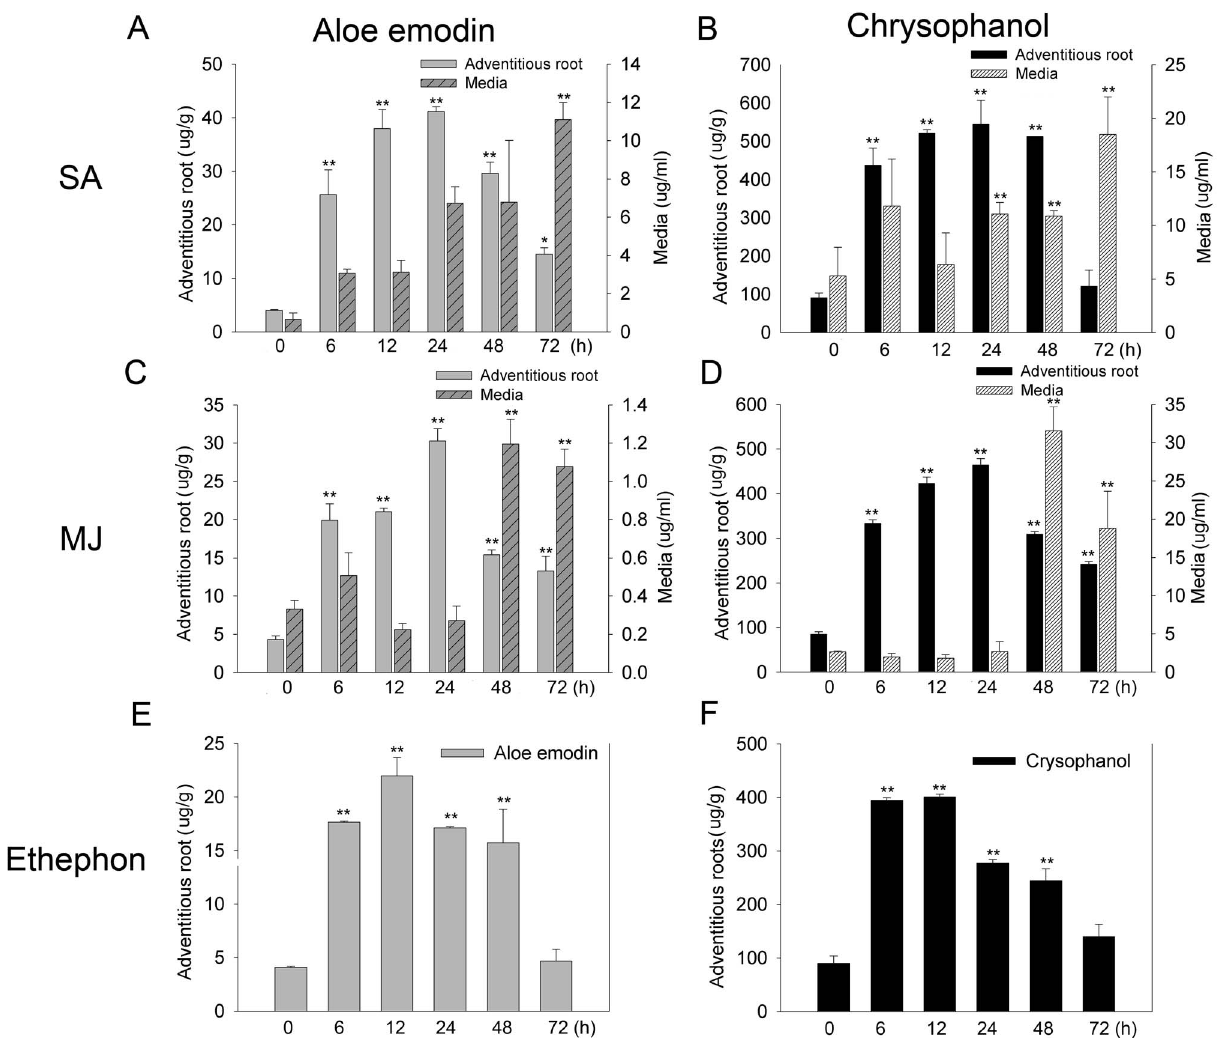
Figure 4. Time-course analysis of aloe emodin and chrysophanol production following elicitation. Content of aloe emodin (A, C, and E) and chrysophanol (B, D, and F) in adventitious roots and culture medium following non and elicitation with 2000 m M SA (A and B), 500 m M MJ (C and D), or 500 m M ethephon (E and F). Data are represented as means of replicate samples 6 standard deviation. Statistical analysis was carried out using the Tukey test (* p , 0.05, ** p , 0.01). Asterisks indicate significant differences compared to aloe emodin and chrysophanol contents obtained from adventitious roots before elicitation.